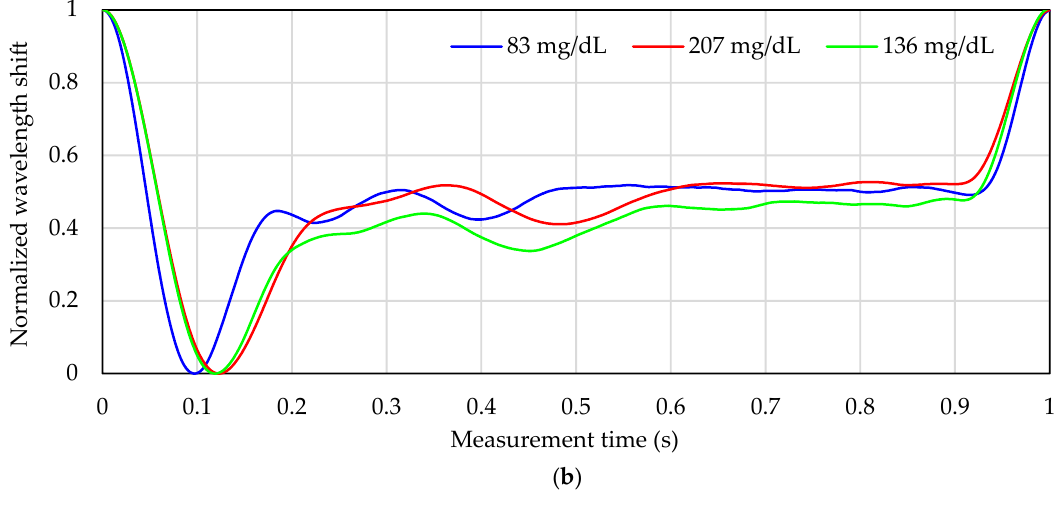
Figure 4. Pulse wave signal in each signal processing method. ( a ) Pulse wave signals in the shortest- time-cut process. (Blood glucose level, Min: 83 mg/dL, Max: 207 mg/dL, Ave.: 136 mg/dL). ( b ) Pulse wave signals in the 1-s-normalization process. (Blood glucose level, Min: 83 mg/dL, Max: 207 mg/dL, Ave.: 136 mg/dL).